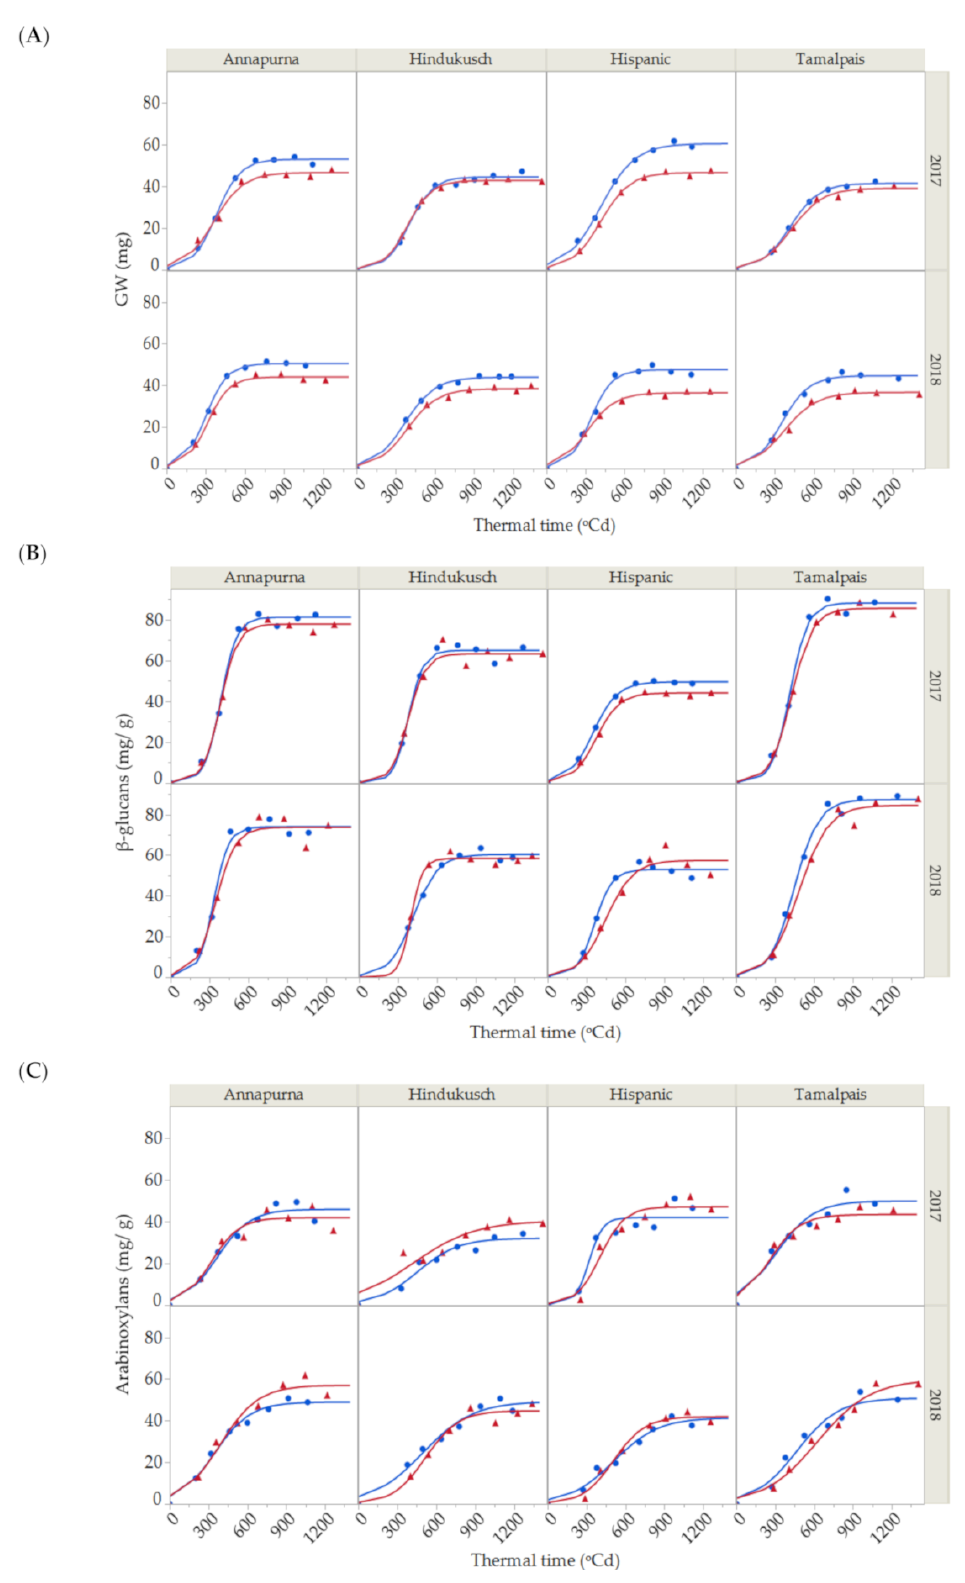
Figure 1. ( A ) Dynamics of grain weight growth, ( B ) β -glucans and ( C ) arabinoxylan contents for the two seasons (2017 and 2018) and four barley genotypes under control (blue points) and thermal stress conditions (red triangles). Solid lines represent the 3-parameter logistic fit for control (blue) and stressed conditions (red) for grain weight, β -glucans and arabinoxylan (Total R 2 = 99.07%, R 2 = 98.30% and R 2 = 94.54%,